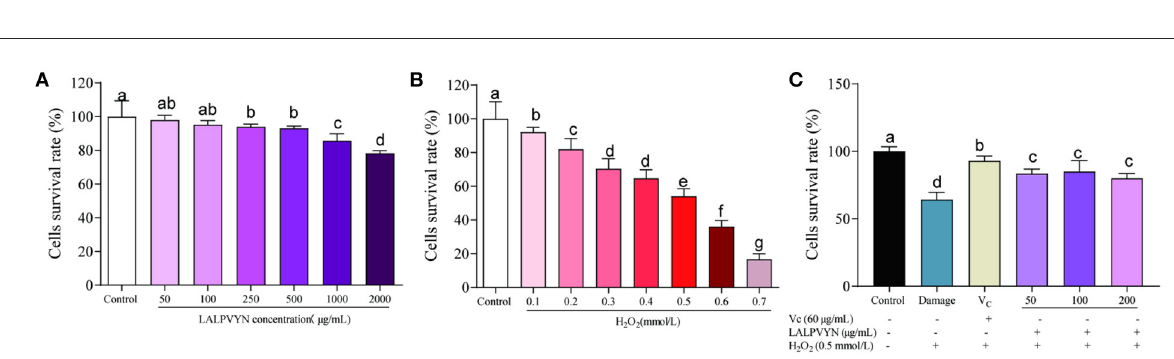
breakdown of peroxidized polyunsaturated fatty acids (42). ROS produced by cells during metabolism can be associated with